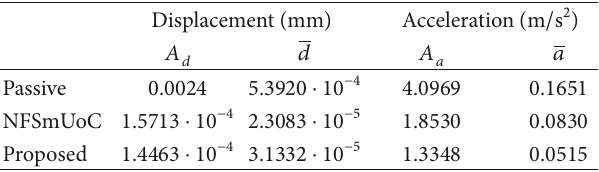
Table 5: Dynamic response of 𝑚 𝑠 corresponding to the broken rail with a disturbance